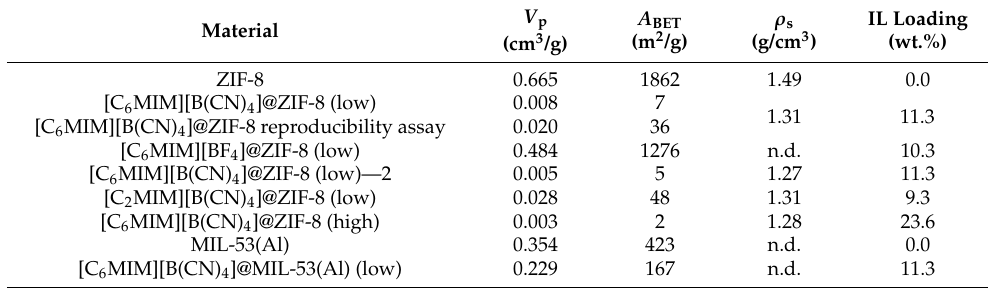
Figure 4. N 2 adsorption/desorption equilibrium isotherms at 77 K of ZIF-8, [C 6 MIM][BF 4 ]@ZIF-8 (low) and different [C n MIM][B(CN) 4 ]@ZIF-8 composites. Closed and open symbols denote the adsorption and desorption data, respectively. Table 1. Total pore volume ( V p ), BET specific surface area ( A BET ), solid matrix density ( ρ s ), and IL mass loading obtained for ZIF-8 and the various IL@ZIF-8 composites. Both V p and A BET were calculated from N 2 adsorption/desorption data at 77 K, while ρ s was obtained from He pycnometry at 333 K.